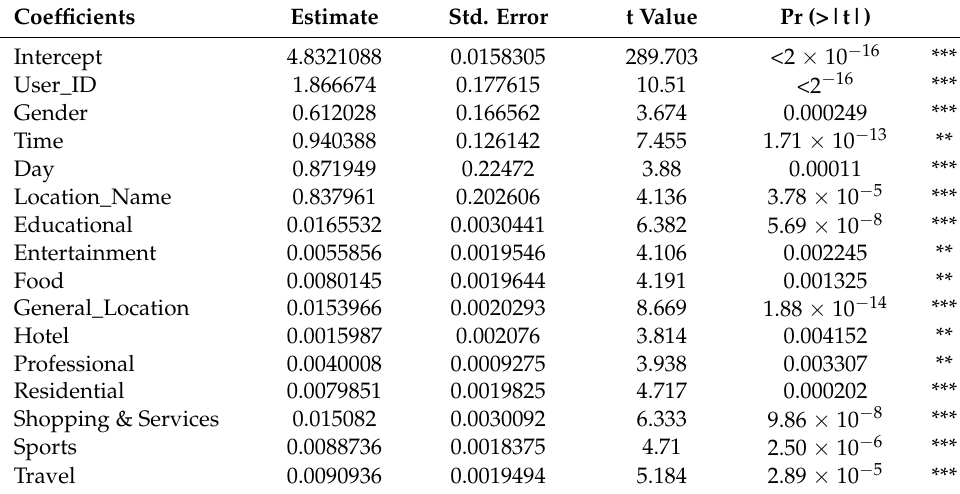
Table 1. Multiple Linear-Regression Model.